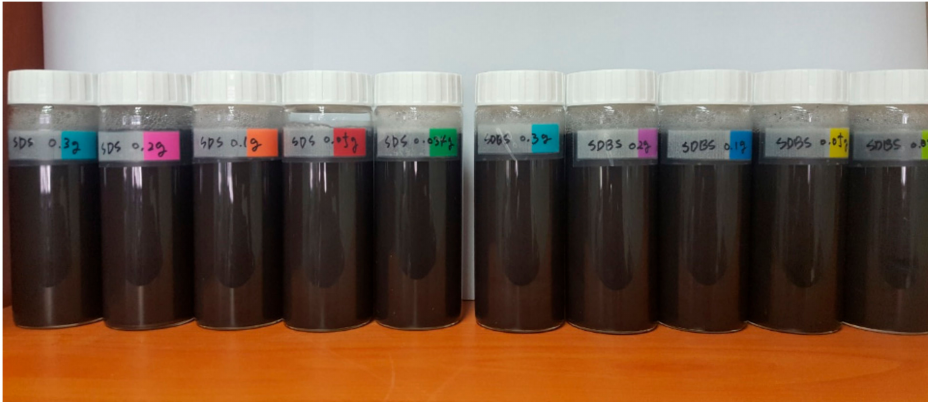
Figure 2. Sample of graphene nanofluids + sodium dodecyl sulfate (SDS) (left)/+ SDBS